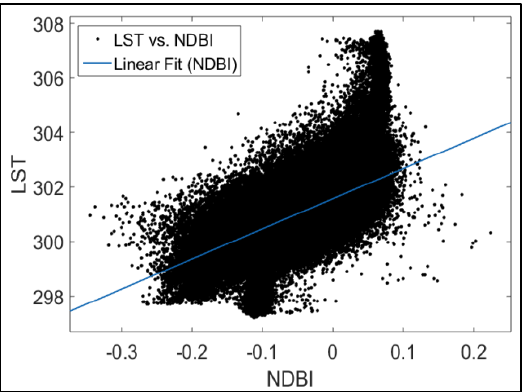
Figure 4.Scatter plot of LST with NDBI